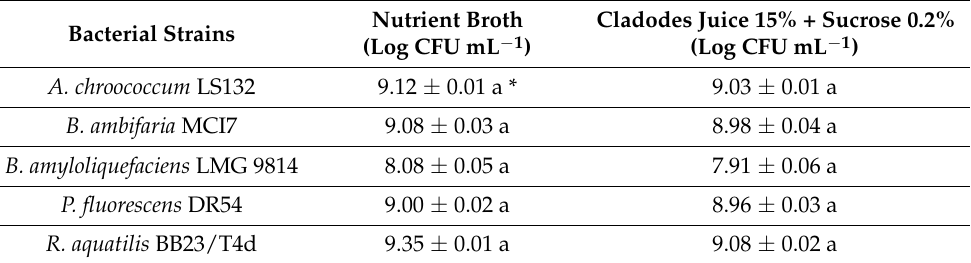
Table 4. Number of viable cells determined at the stationary phase of batch culture performed in 15 L bioreactor. Bacterial